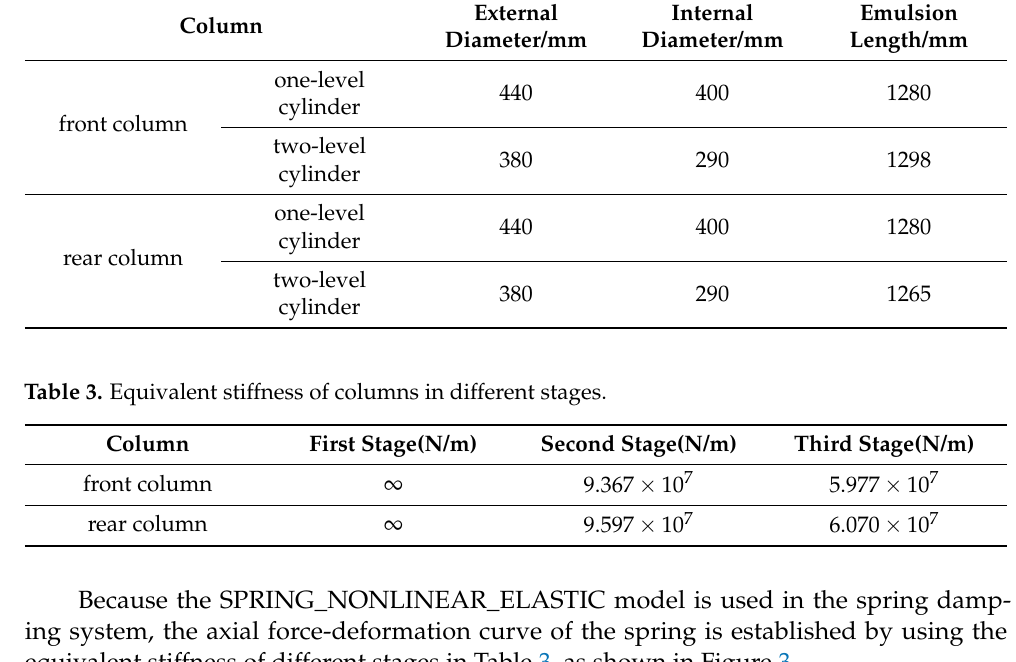
Table 2. Dimension parameters of column structure.